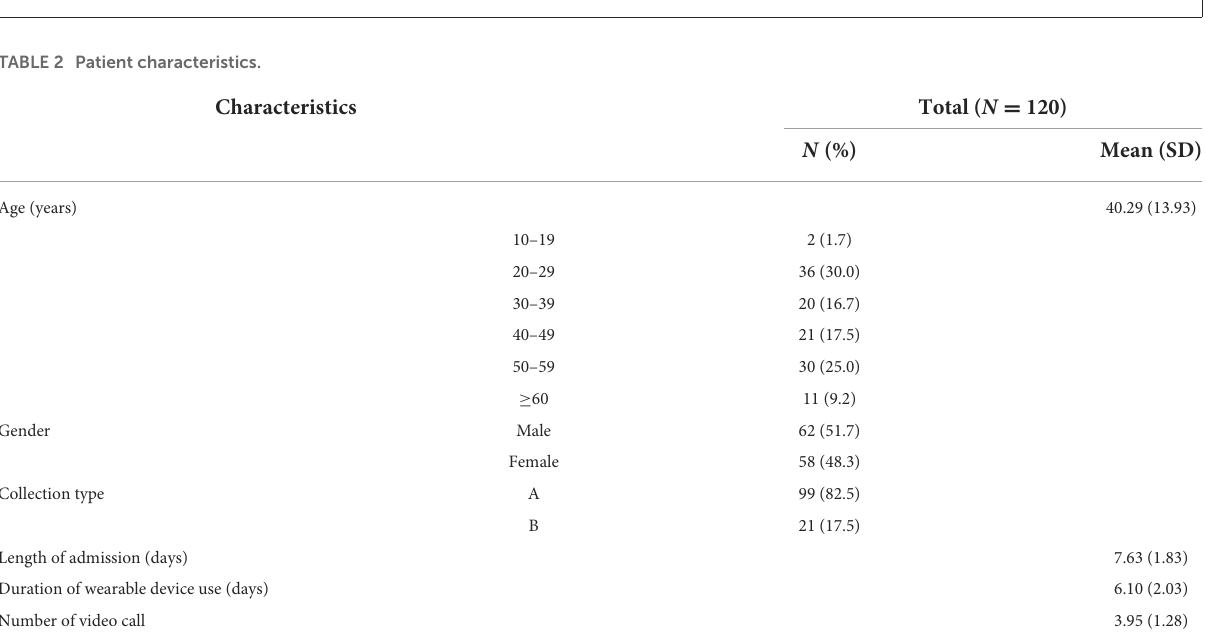
FIGURE2 Detailed process of the trial.